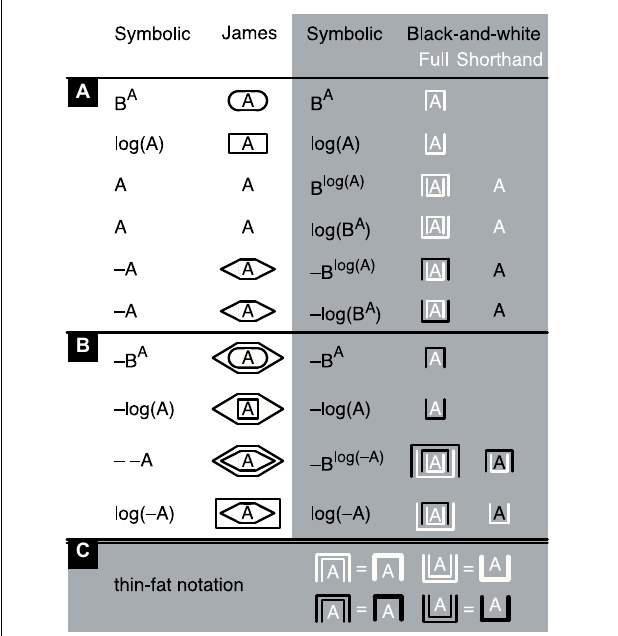
FIGURE 6 | Definitions. In black on white (left), symbolic operations are shown with their James-algebraic translations. In black or white on gray (right), equivalent symbolic operations are shown with their full black-and-white translations and shorthand versions. These shorthands are merely a convenience and can at any time be replaced by their full versions. (A) Basic operations. (B) Some operations derived from the basic ones. (C) Equivalent fat notations of the exponent of an exponent of A and the logarithm of a logarithm of A (white), as well as their negative versions (black). The logarithms and exponents are assumed to have the same arbitrary base B. Lacking a better alternative, variables are still represented by